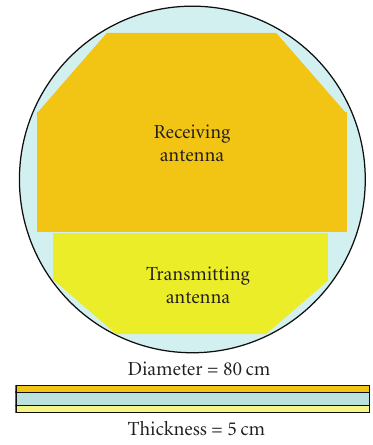
Figure 3: Final version size and geometry.